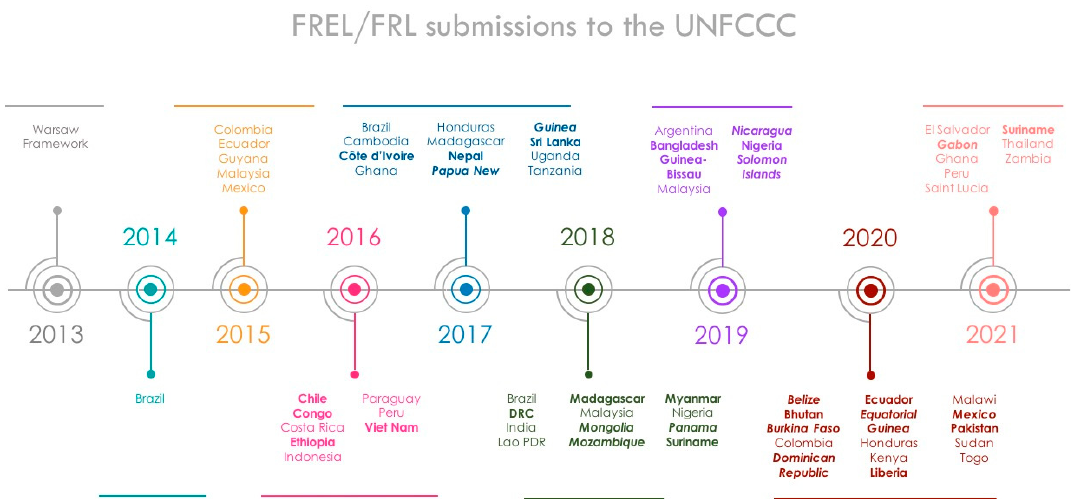
Figure 2. FREL/FRL submissions to the UNFCCC. Countries in bold italic use Collect Earth to collect Activity Data information, while countries in bold used Collect Earth to evaluate map accuracy.